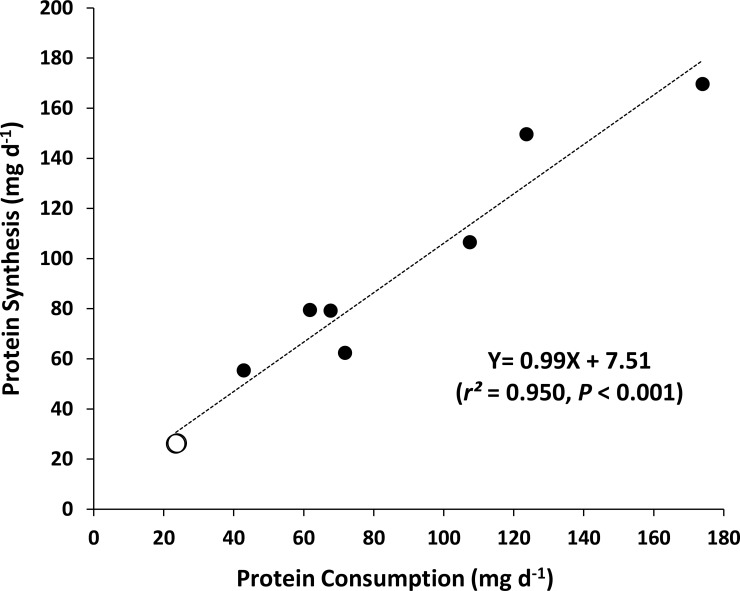
Effect of protein consumption on protein synthesis in fishes at 14–16°C.The relation between mass-corrected whole-animal absolute rates of protein consumption (Ar, mg protein d-1) and protein synthesis (As, mg protein synthesized d-1) for various teleost fish species at 14–16°C. Original consumption and synthesis data have been mass-corrected to a standard mass of 12 g. Information on species, actual body mass and source reference are presented in S1 Table. Data from the present study are indicated by the large open circles on the plot.